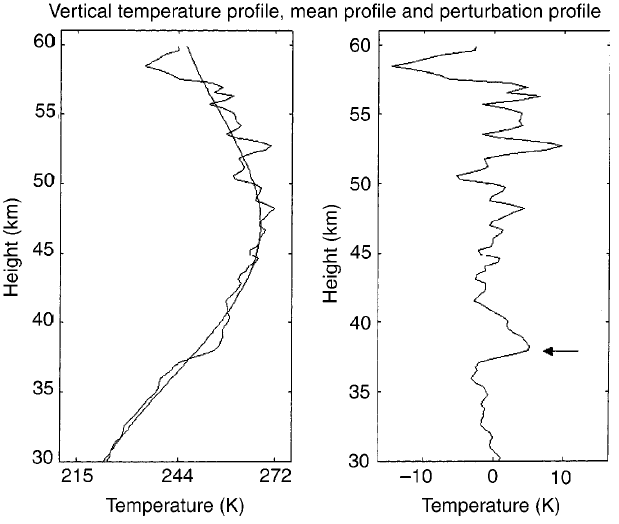
Fig. 1. Averaged vertical temperature profiles over twelve 30-min integrated profiles with 300-m spatial resolution obtained from Rayleigh lidar measurements on June 21, 1994, from 30 km to 60 km height. Raw profile, mean profile resulting from the application of a low-pass filter with a cuto(cid:128) of 12-km vertical wavelength ( left panel ) and perturbation profile ( right panel ). The arrow indicates the location of enhancement of the original wave